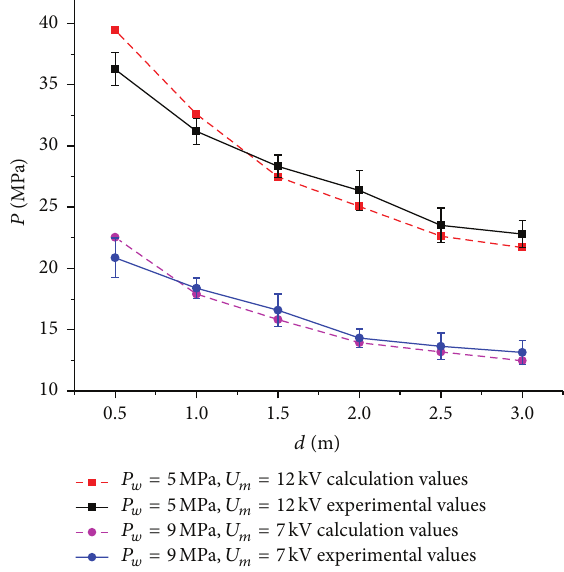
Figure 12: Comparison between new experimental values and calculated